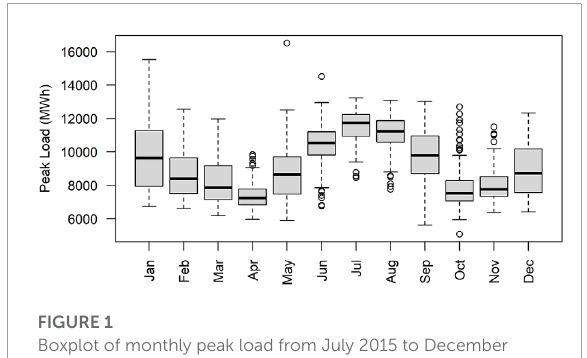
FIGURE 1 Boxplot of monthly peak load from July 2015 to December 2020.